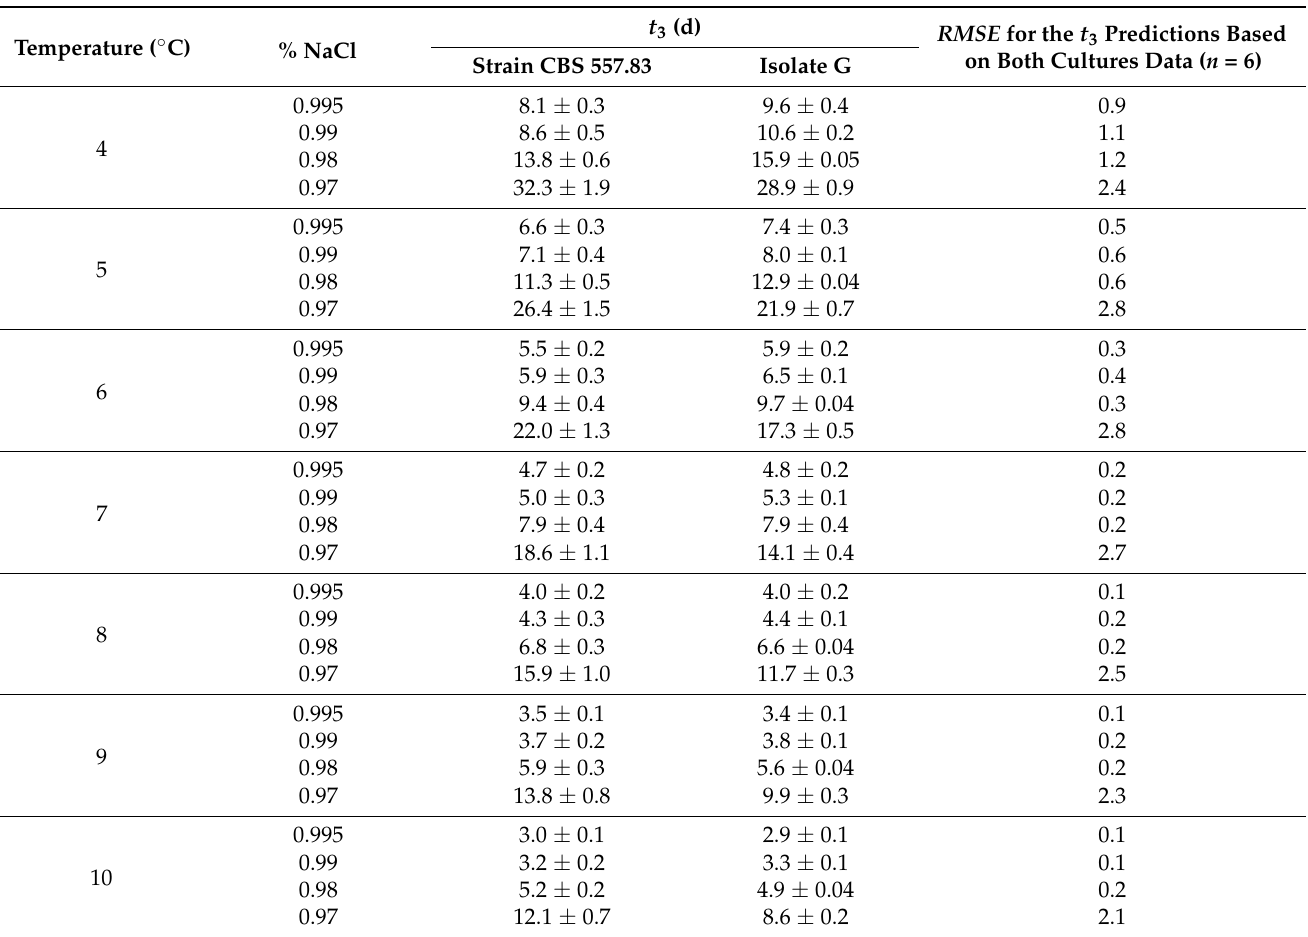
Table 3. Comparison of the time needed for G. candidum to create 3 mm